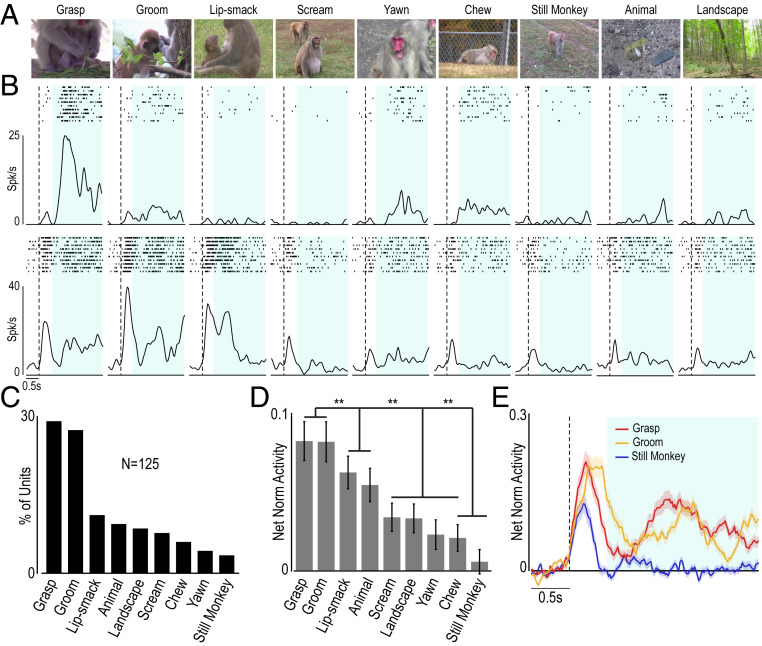
Control experiment. AIP preference for OMA relative to other natural video stimuli. (A) Frames taken from each of the nine presented videos. (B) Rasters and PSTHs illustrating the response of two AIP video-selective single neurons (in rows) to the nine video stimuli illustrated in A. Light blue shading indicates the epoch of interest for statistical analysis. Other conventions are as in Fig. 1C. (C) Frequency distribution of selective units based on their preferred video (χ2 = 67.62, P < 0.001). (D) Population response of all selective units to each of the presented videos. A one-way repeated-measures ANOVA followed by a Bonferroni post hoc test revealed no significant difference between grasp and groom, which in turn evoked a stronger discharge relative to all of the remaining stimuli. (E) Temporal profile of the selective units’ response to the preferred (grasp and groom) and not preferred (still monkey) videos. The shading around each curve corresponds to 1 SE. **P < 0.05.